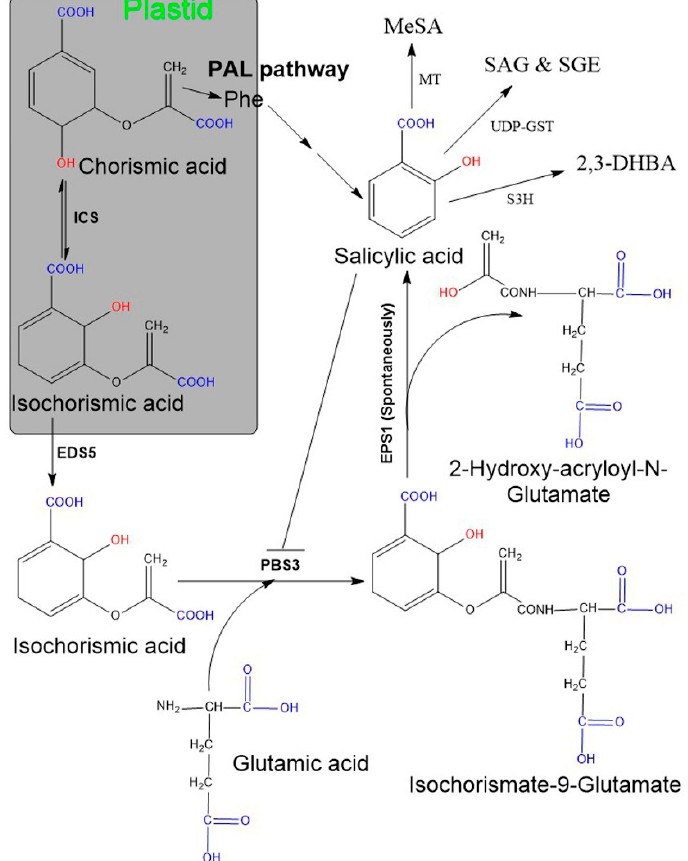
Figure 1. Salicylic acid biosynthesis in plants. Plants possess two pathways (ICS and PAL) and both start from chorisimic acid. In the ICS pathway isochorismate requires two additional genes, named EDS5 and PSB3 . The EDS5 -encoding enzyme exports isochorismate from the plastid to the cytosol. Further, isochorismate attached to glutamic acid with the help of PBS3 (encoding cytosolic amidotransferase), consequently leads to the formation of an unstable compound, isochorismate-9-glutamate. The non-enzymatic decomposition of isochorismate-9-glutamate then yields salicylate and 2-hydroxy-acryloyl-N-glutamate as final products. The PAL pathway includes the amino acid, phenylalanine as an intermediate compound and comprises multiple sequential enzymatic steps, indicated by several arrows. SA may exist in various modified functional forms, for instance, SAG/SGE, MeSA, 2,3-DHBA. Abbreviation: EDS5 ( enhanced disease susceptibility 5 ), EPS1 ( enhanced Pseudomonas susceptibility 1 ), PBS3 ( avrPphB susceptible 3 ), SAG (SA glucoside), SGE (SA glucose ester), MeSA (methyl salicylate), 2,3-DHBA (2,3-dihydroxybenzoic acid), MT (methyl- transferases), UDP-GST (uridine diphosphate glucose-glycosyltransferase) S3H (SA 3-hydrox-